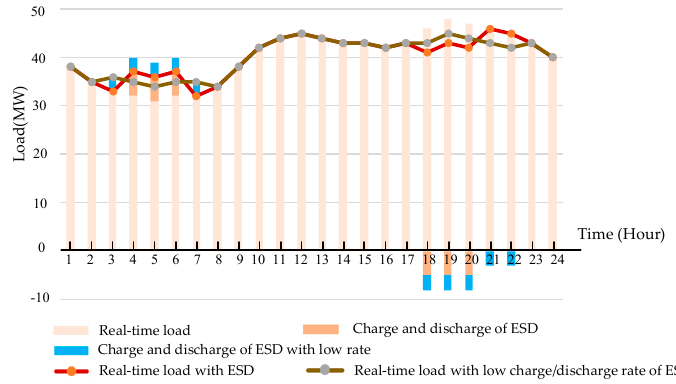
Figure 7. Comparison of load profile in Scheme 4.41with the original scheme.